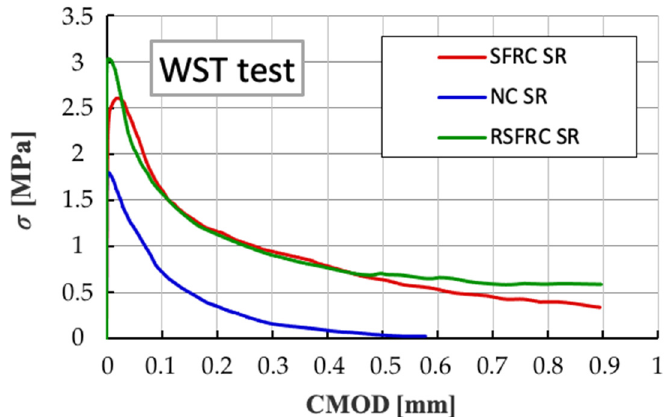
Figure 18. Comparison of diagrams of σ -CMOD relationships for concrete without fibres (NC) and with fibres (SFRC and RSFRC) at WST test.